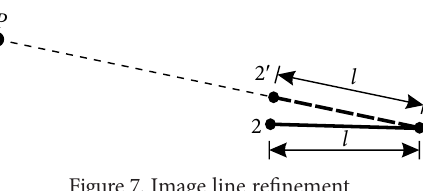
Figure 7. Image line